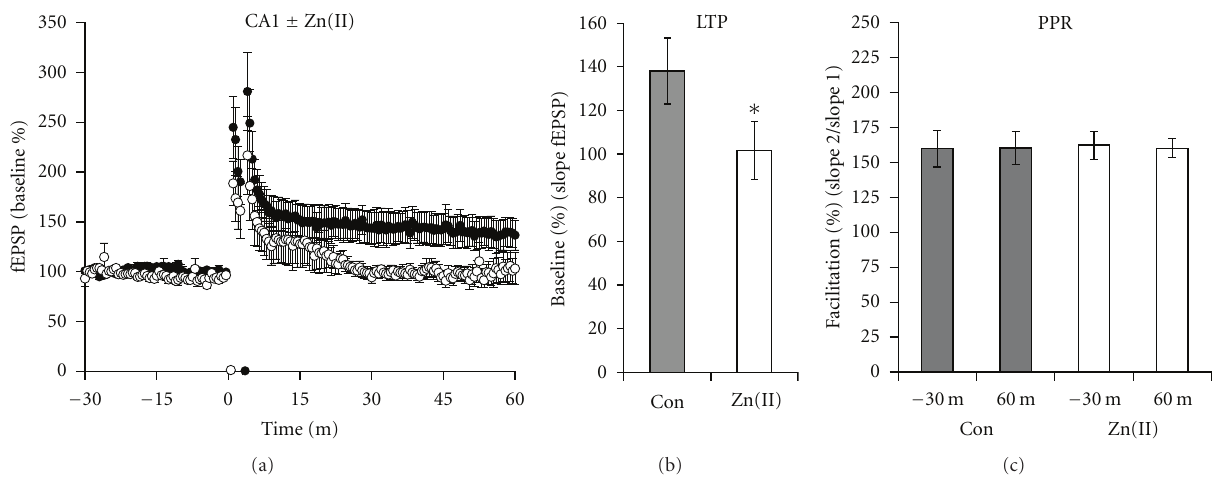
Figure 6: Zinc blocked LTP but did not change the PPR after LTP in the CA1 region. (a) LTP was present in control slices (filled circles) but was blocked by 5 μ M ZnCl 2 (open circles). (b) The magnitude of the LTPs averaged one hour after the tetanus was reduced from 138 . 0 ± 15 . 1% to 101 . 5 ± 13 . 2% in zinc-treated slices ( P = 0 . 013, n = 8). (c) The PPR after the expression of LTP was not a ff ected by zinc (open circles). All slices were tetanized at t = 0m in this